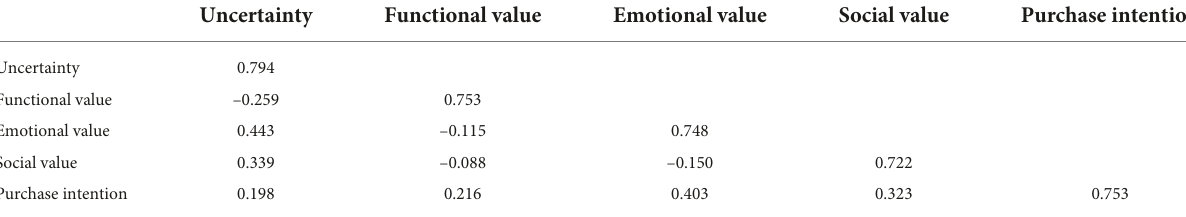
TABLE 3 Discriminant validity analysis result.